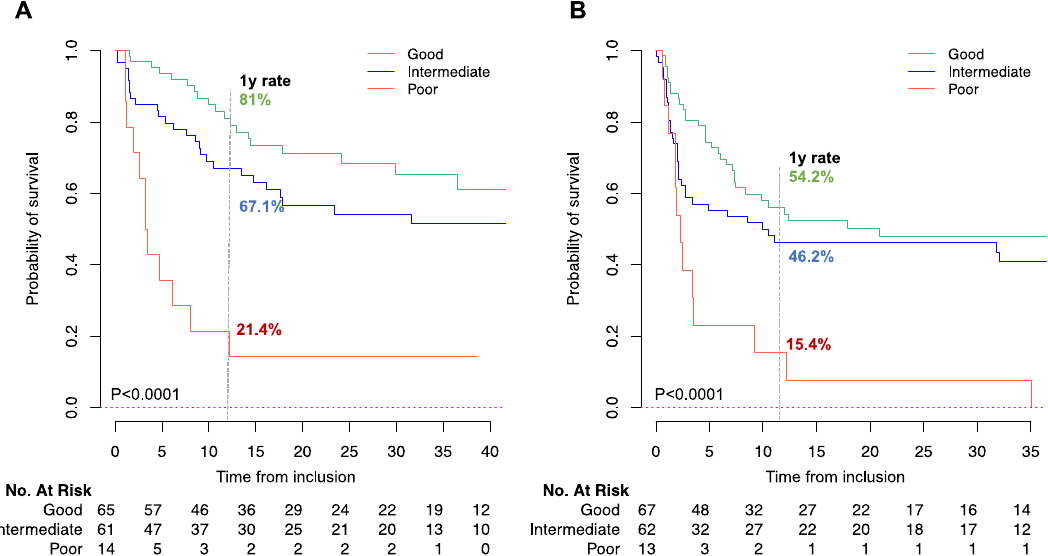
Figure 1. Kaplan Meier curve for OS ( A ) and PFS ( B ) according to LIPI score. Log Rank p < 0.0001 for both endpoints. The numbers at risk differ between OS and PFS, due to missing data in OS/PFS status or duration.